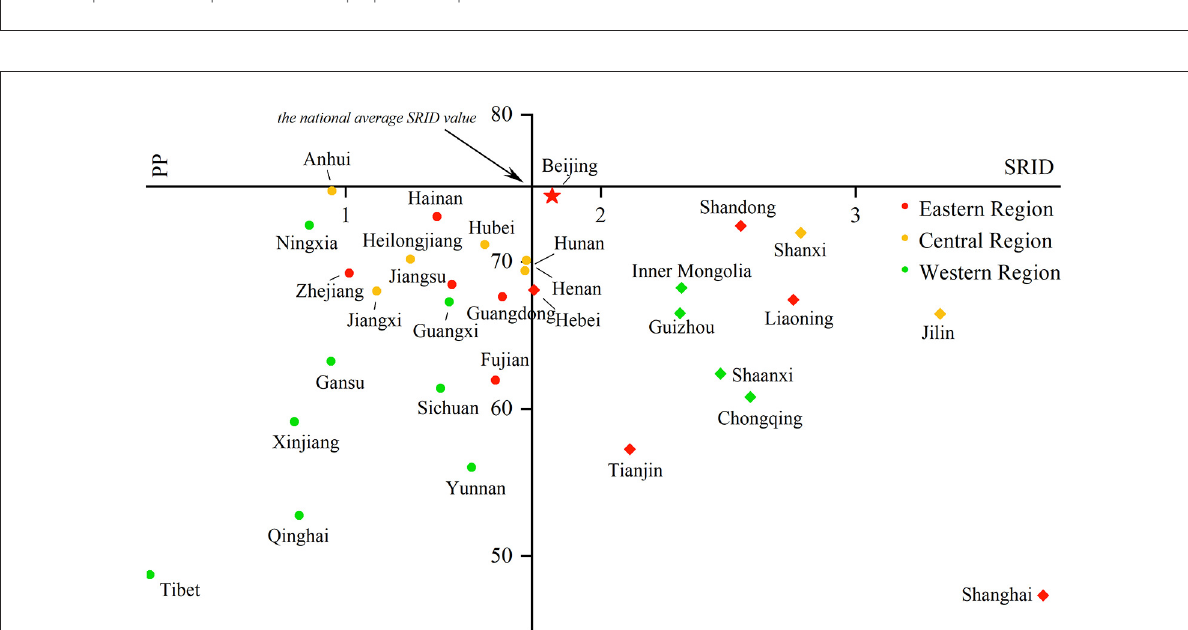
FIGURE6 Scatter plot with four quadrants for the proportion of professionals in 2017.